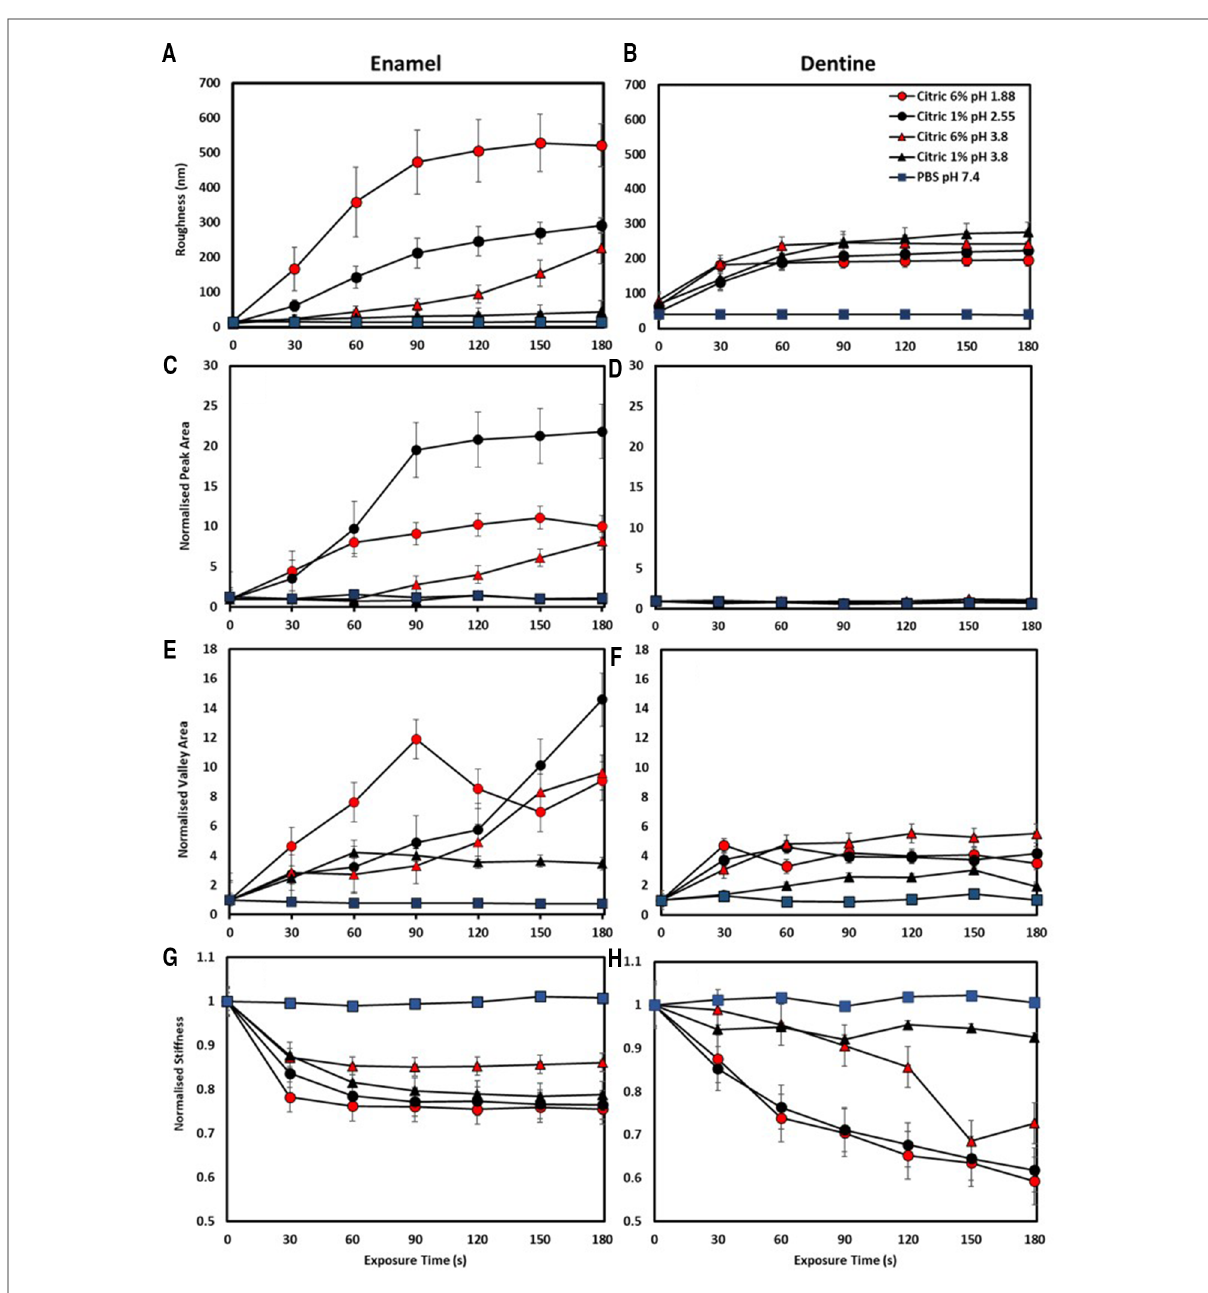
statistically signi fi cant differences ( P